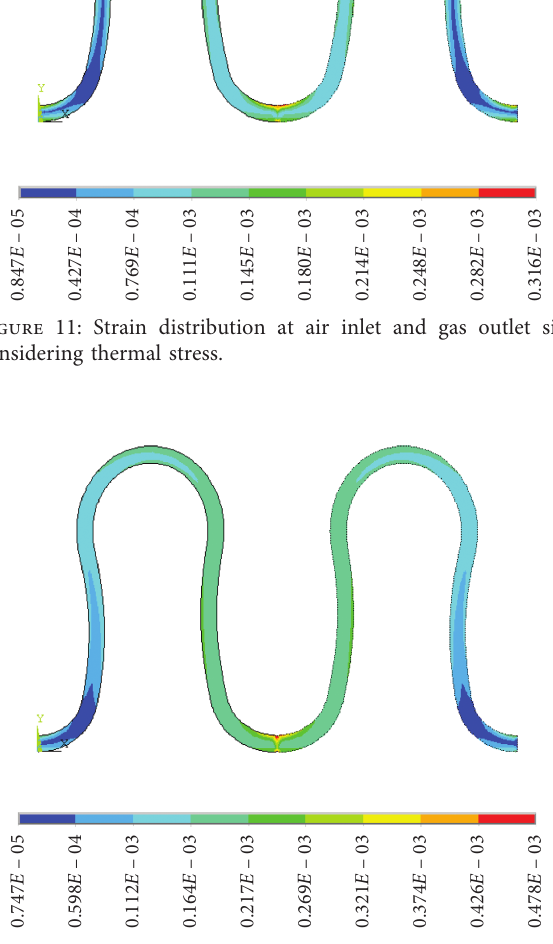
Figure 10: Stress distribution at air outlet and gas inlet side considering thermal stress